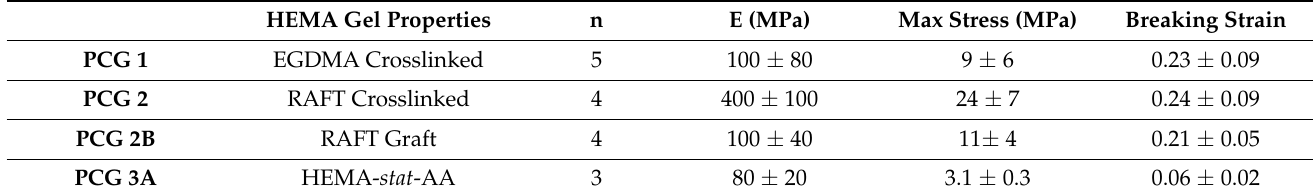
Figure 5. Representative engineering stress/strain curves of PCN 1 , 2 , 2B and 3A . Table 4. Mechanical performance of crosslinked